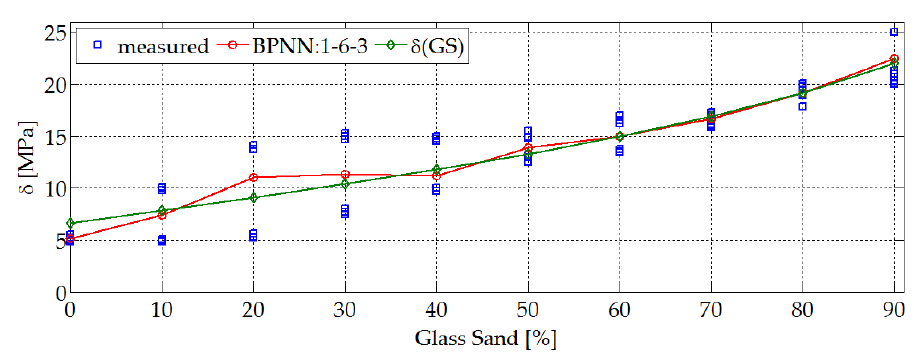
Figure 8. Compressive strength ( δ ) as a function of glass sand content [MPa].